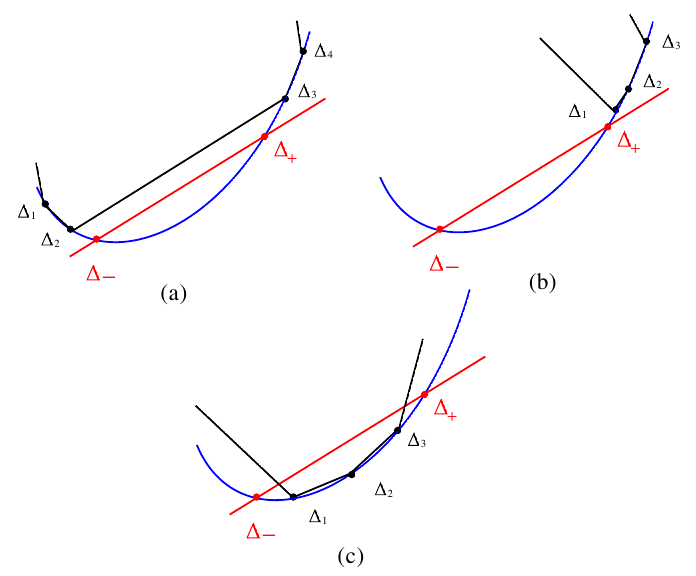
Figure 12 . In order for the unitarity polytope to intersect with the crossing plane, we must have operators lying between (cid:1) (cid:0) ; (cid:1) + . Case (a) and (b) demonstrates the cases where all the f g operators are outside this region, and hence cannot intersect with the crossing line. For case (c) it does